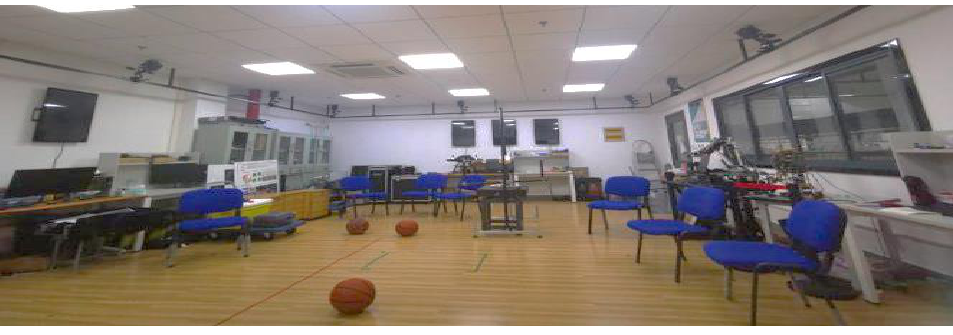
Figure 29. The view of the indoor test scene.